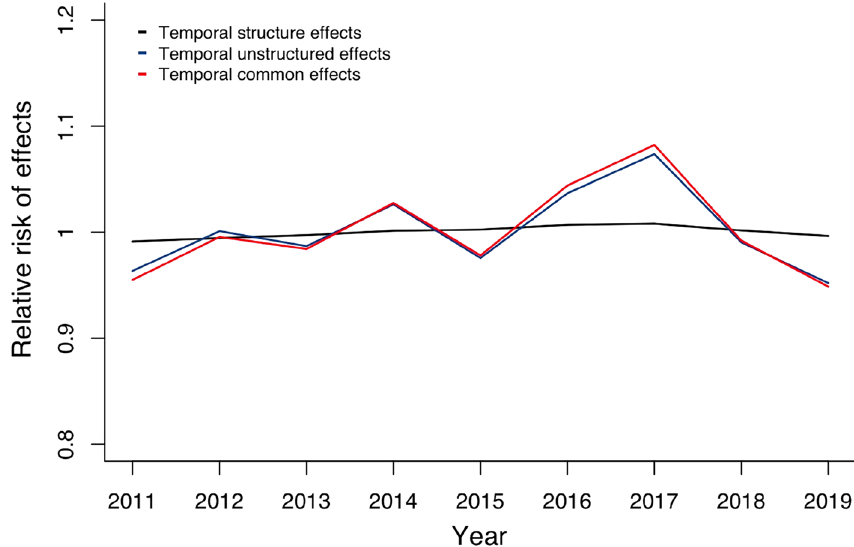
Figure 2. The posterior mean of the relative risk of the temporal effects in the model (1).